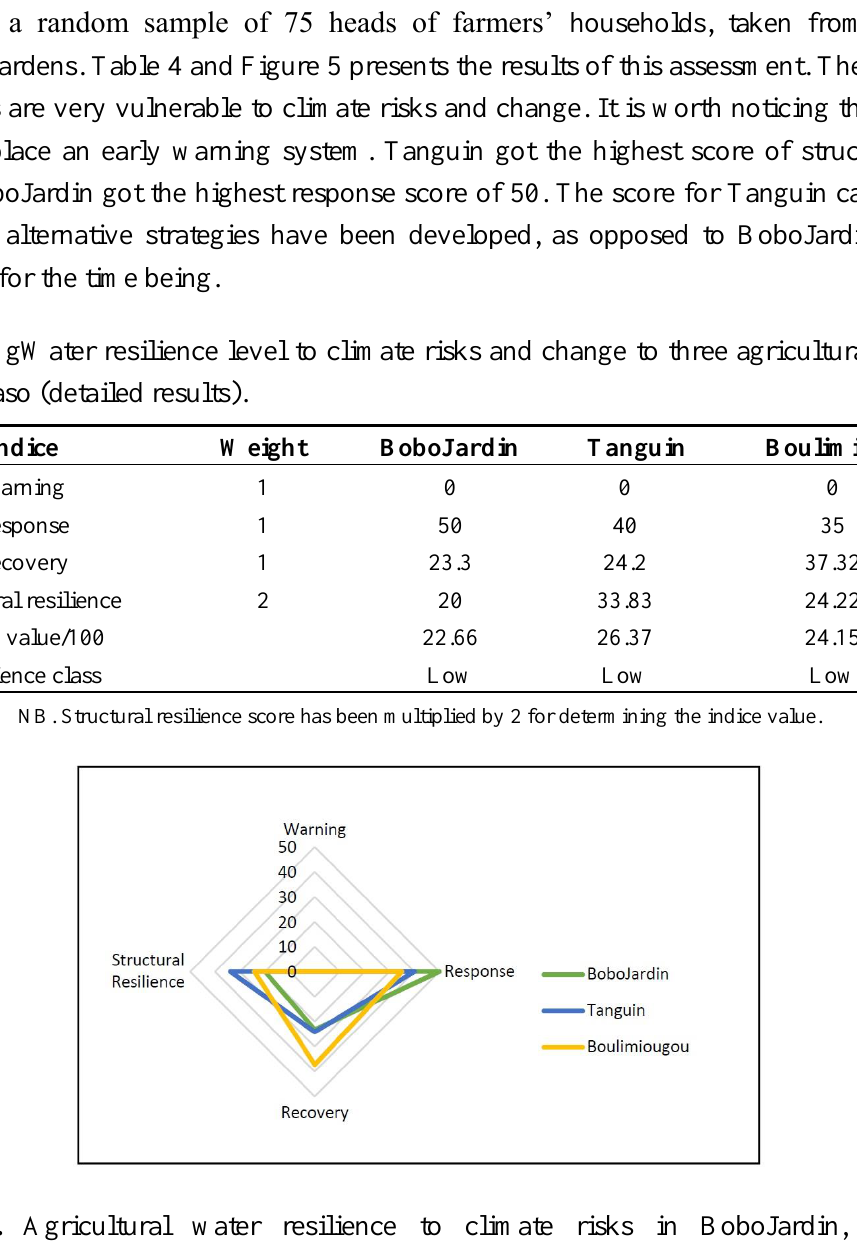
Figure 5. Agricultural water resilience to climate risks in BoboJardin, Tanguin and